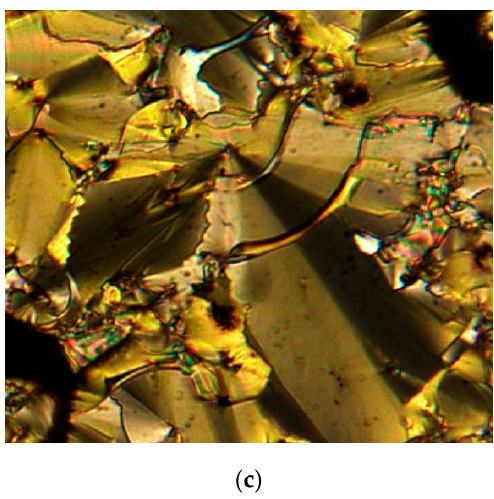
Figure 13. The optical photomicrographs of compounds 6c–e in the heating cycle showed the broken focal conic fans of SmC in the cooling cycle, ( a ) 150.11 ° C for 6c , ( b ) 144.67 ° C for 6d , and ( c ) 130.55 ° C for 6e (Magnification: 20 × 0.25).